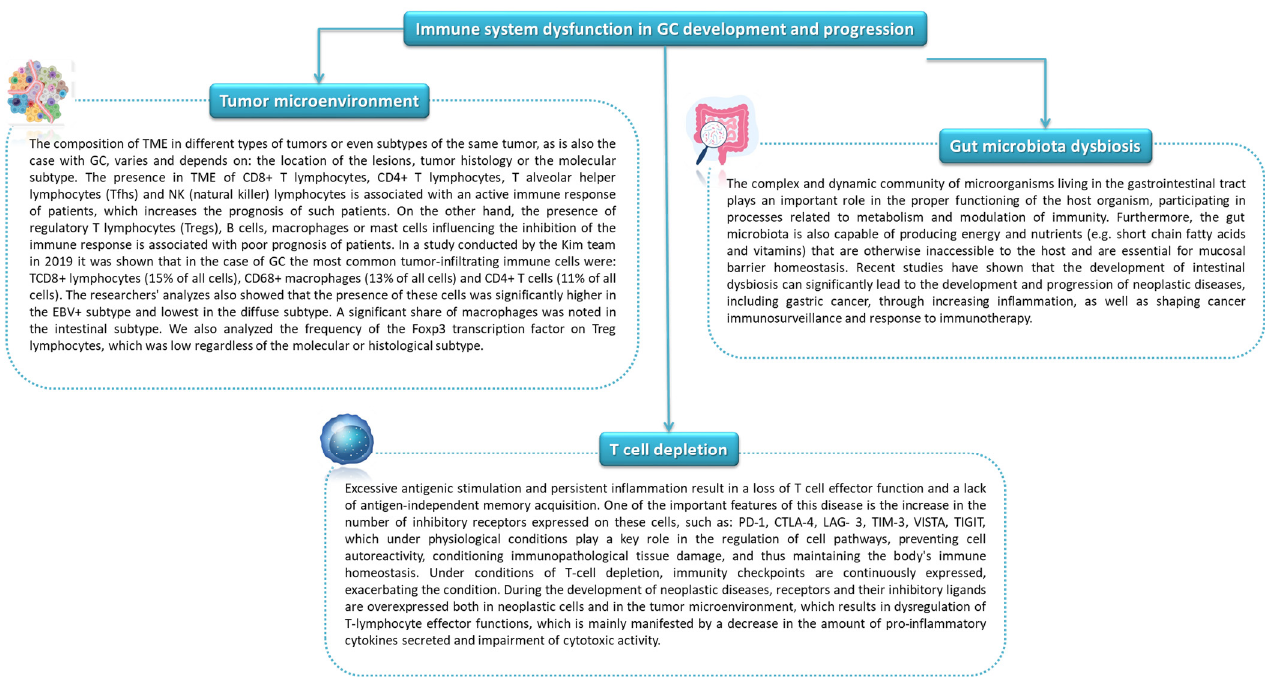
Figure 7. Immune system dysfunction in GC development and progression (based on [105–109]).